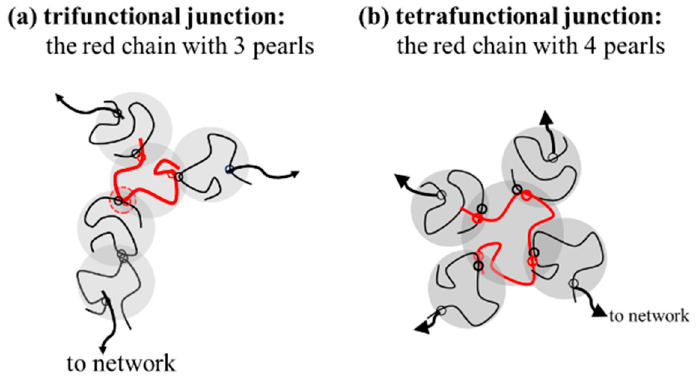
Figure 11. The specific red chains with 3 and 4 pearls acting as ( a ) trifunctional junction ( f = 3) and ( b ) tetrafunctional junction ( f = 4). ( b ) tetrafunctional junction ( f =